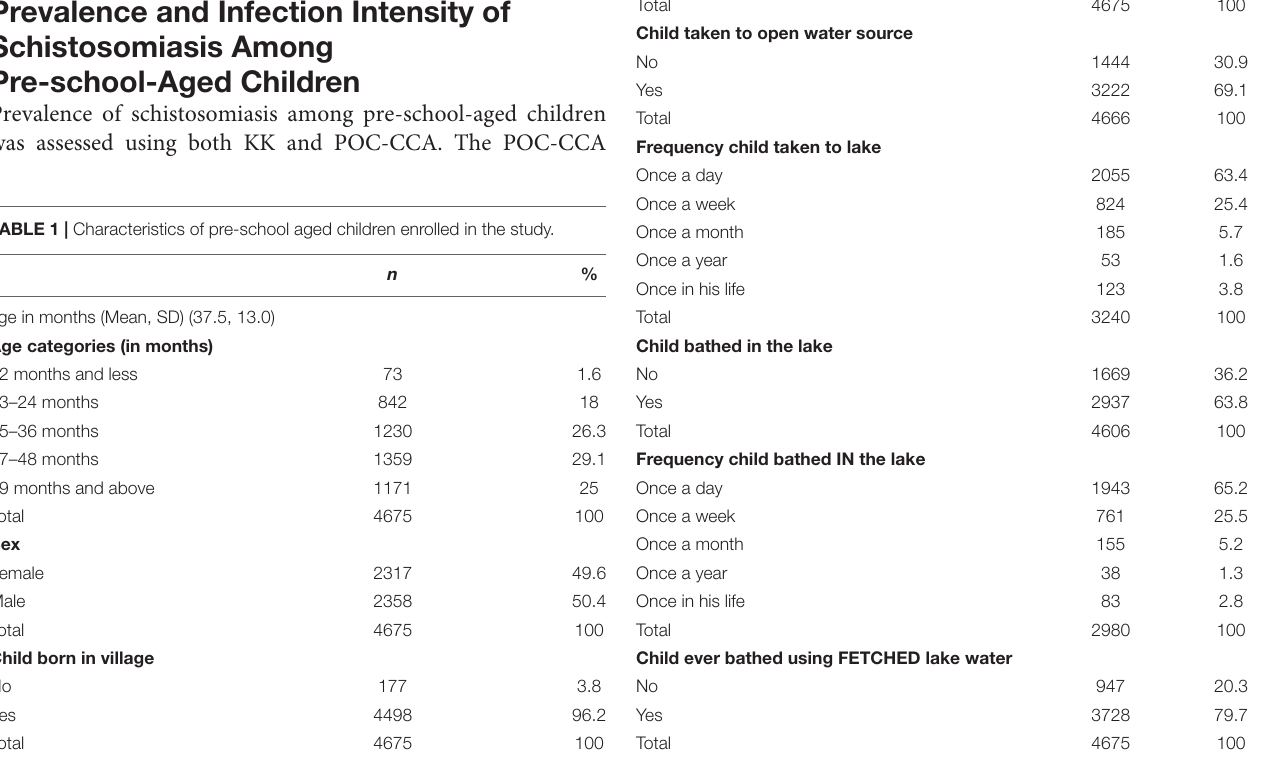
TABLE 1 | Characteristics of pre-school aged children enrolled in the study.